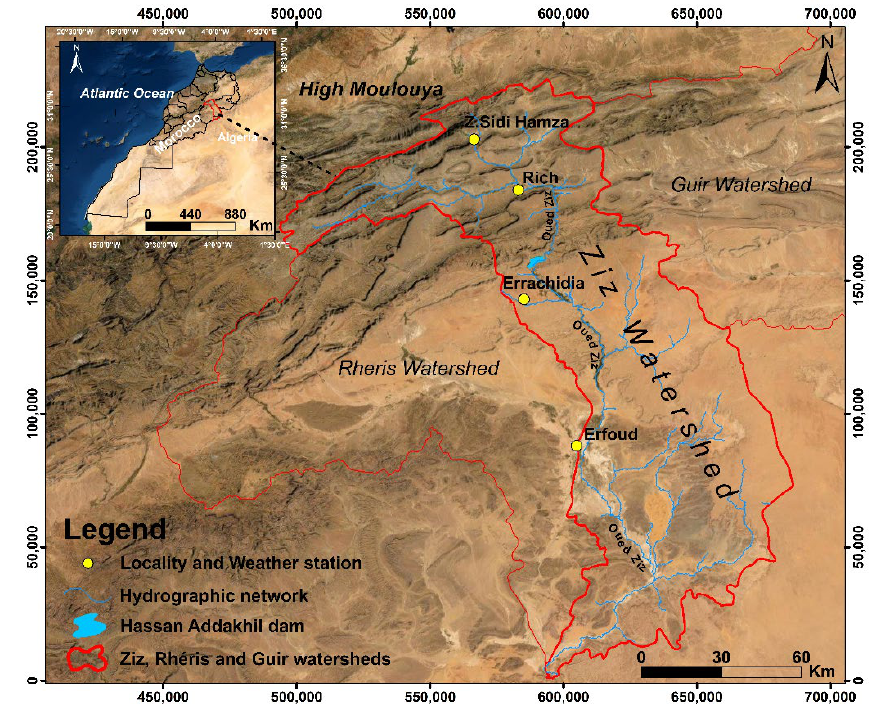
Figure 1. Geographical location and hydrographic network.